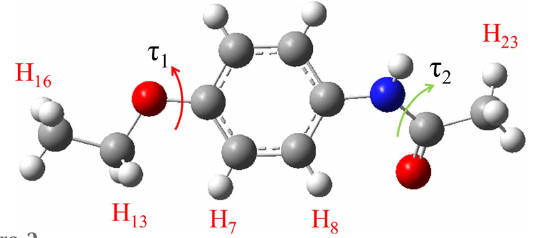
Figure 2 Rotatable single bonds of phenacetin related to conformational change.